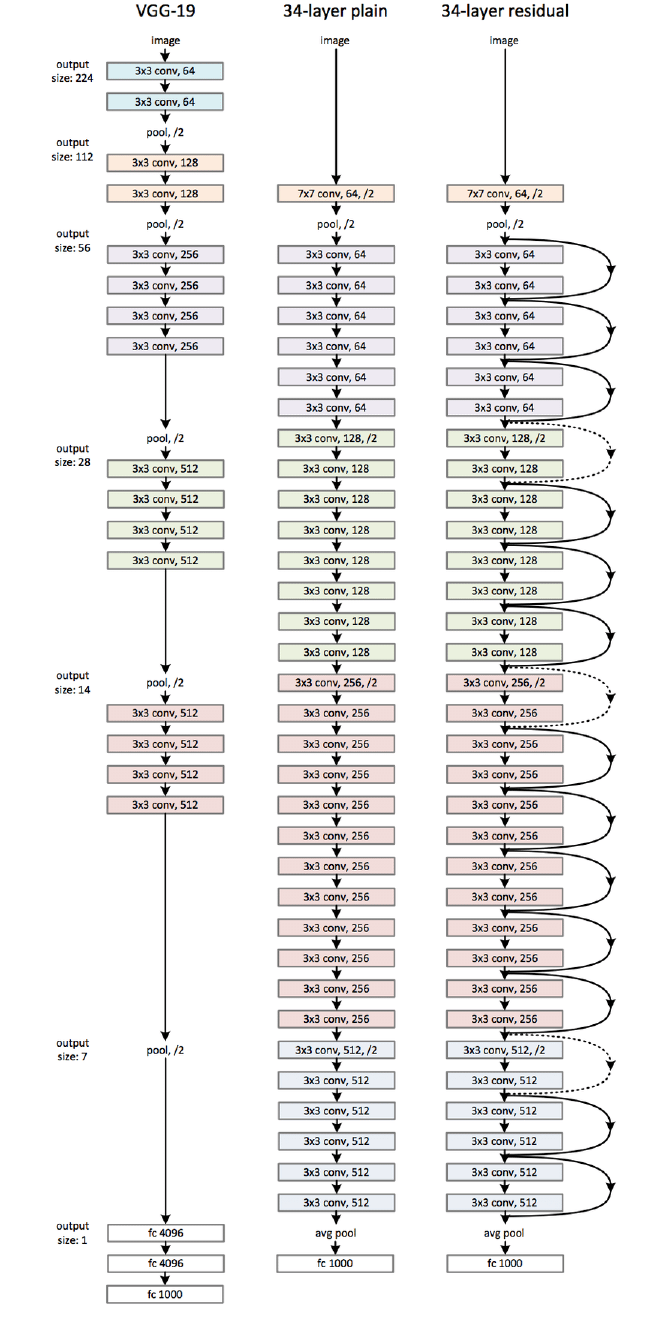
Figure 3. ( Left ): the VGG-19 model as a reference. ( Middle ): a plain net- work with 34 parameter layers. ( Right ): a residual network with 34 parameter layers